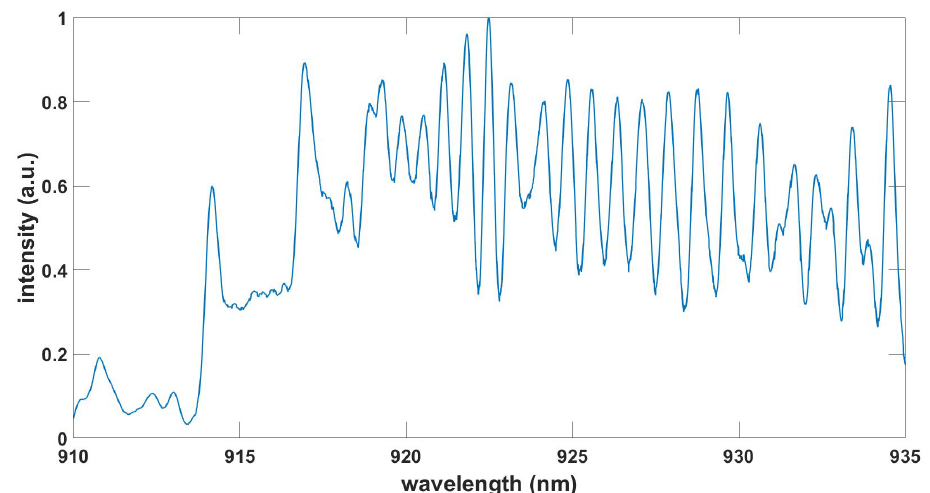
Figure 3. Computed CN red spectrum, ∆ v = + 1, δ λ = 0.38nm, T = 7.5 kK.